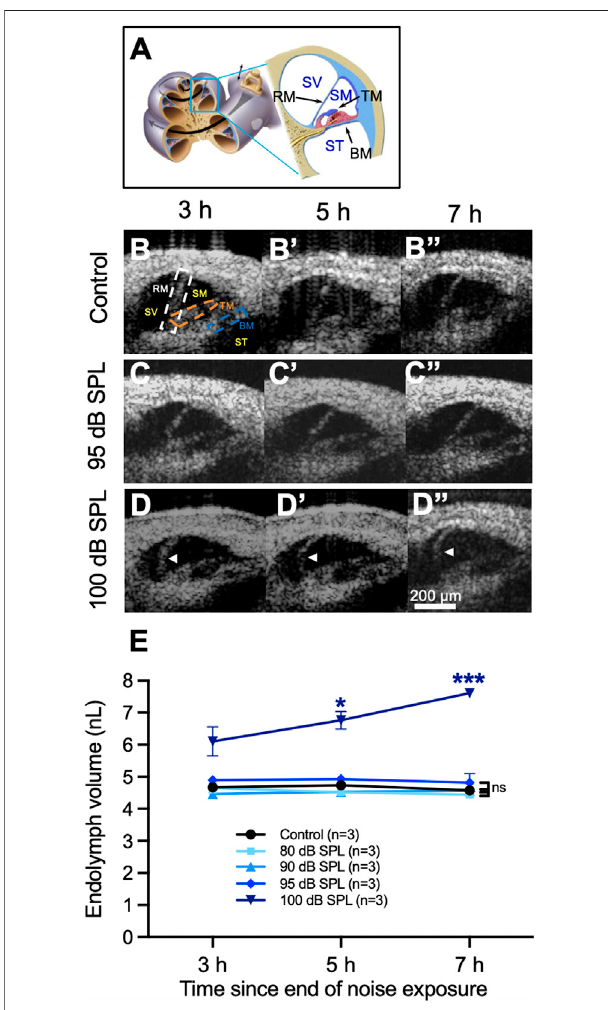
FIGURE1| Endolymphatichydrops develops after 2 h of100 decibel (dB) sound pressure level (SPL) noise exposure. (A) Diagram of the mouse cochlea indicating the location where optical coherence tomography (OCT) was performed within the apical turn. Locations of Reissner ’ s membrane (RM), basilar membrane (BM), tectorial membrane (TM), scala vestibuli (SV), scala media (SM) and scala tympani (ST) are shown. (B) OCT images from a representative control mouse demonstrate normal endolymph volume and no change in the position of RM over time. Locations of the same structures from panel (A) are shown in the fi rst panel. (C) OCT images from a mouse exposed to 95 dB SPL noise also demonstrate normal endolymph volume and no bulging of RM over time. (D) Endolymphatic hydrops is apparent at 3 h following 100 dB SPL noise exposure and progressively grows over the next 4 h. White arrow heads indicate the bowed position of RM. (E) Quanti fi cation of endolymph volume measured over time in mice exposed to 80, 90, 95, and 100 dB SPL as well as control mice that were not exposed to noise. Endolymph volume increased over time in mice exposed to 100 dB SPL and was signi fi cantly greater than control mice at 5 and 7 h following noise exposure. Endolymph volumes in mice exposed to lower noise intensity levels were not signi fi cantly different than in control mice. Endolymph volume represents the volume of the scala media over a segment of basement membrane that is 150 μ m in length. Sample sizes are expressed in number of mice. Error bars indicate standard error. * p < 0.05, *** p < 0.001.